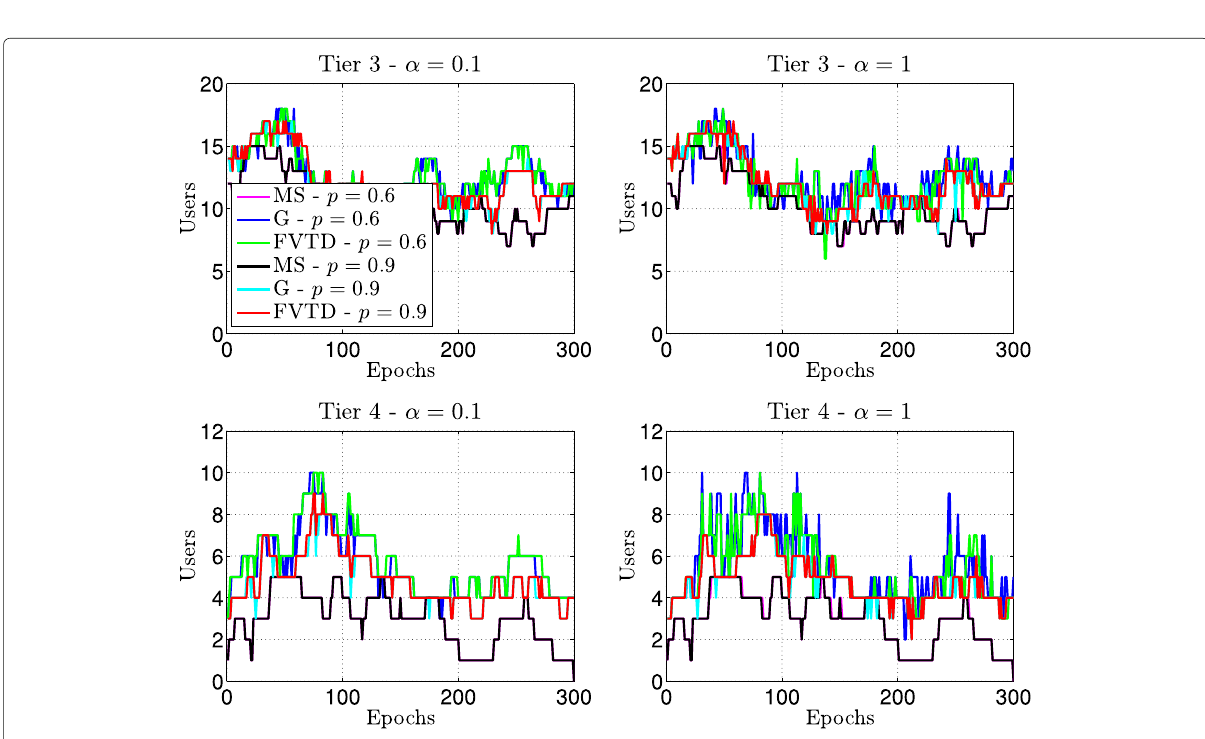
Fig. 9 Evolution of user association in tier 3 and tier